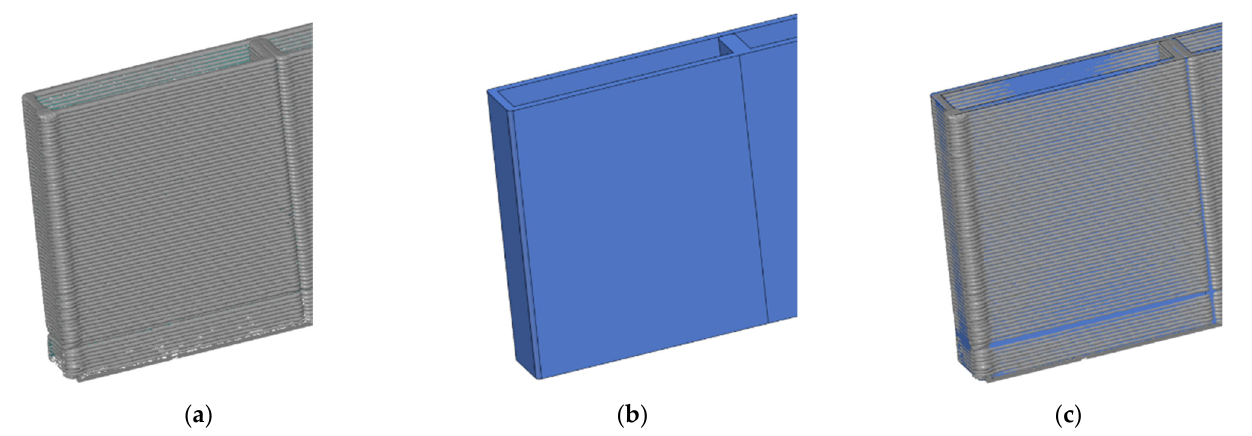
Figure 5. ( a ) Actual (scanned) model (mesh), ( b ) nominal model (CAD), ( c ) models aligned to a common coordinate system.